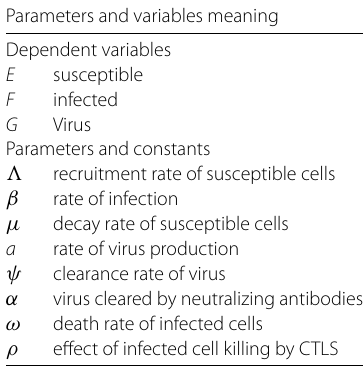
Table 1 Parameter meanings of EIAV